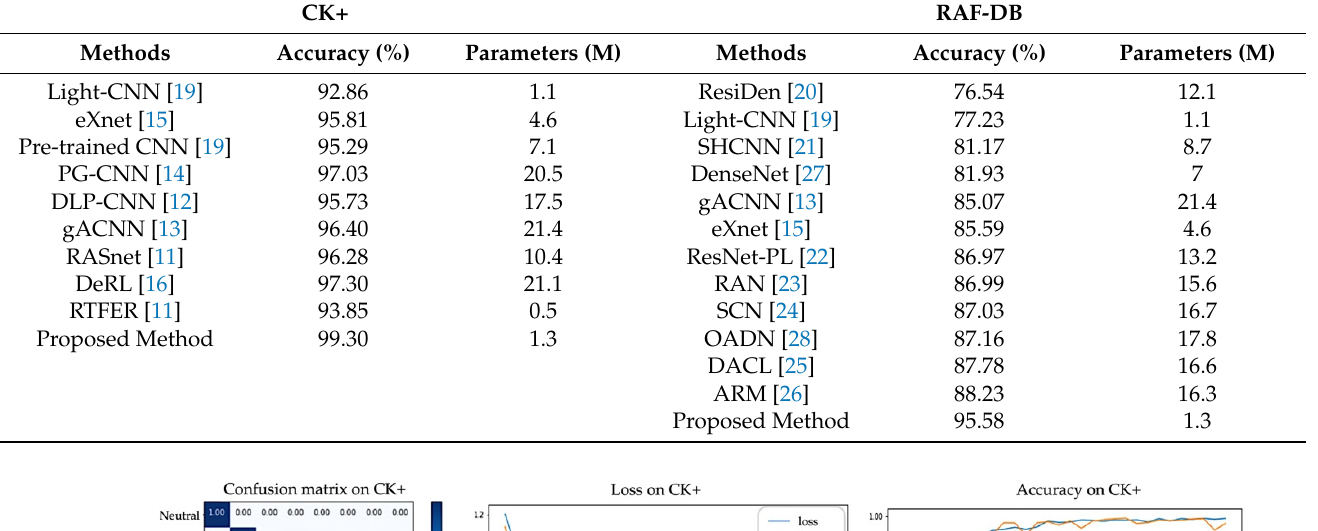
Table 3. Accuracy metrics of the proposed method on the CK+ and RAF-DB data sets.